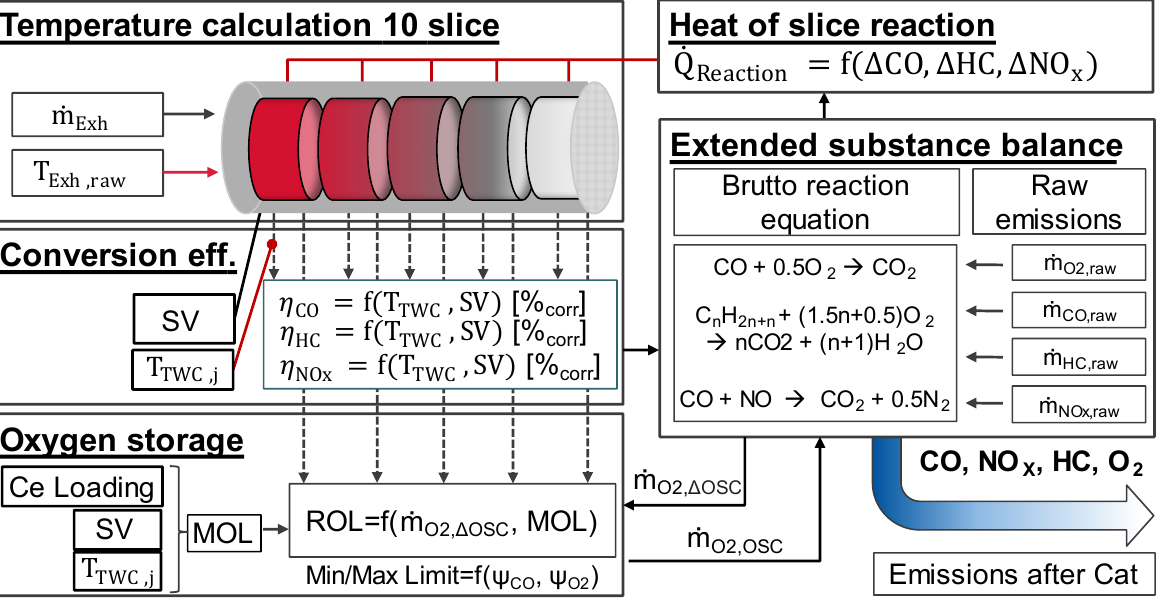
Figure 3. Simplified structure of the three-way catalyst for the main gaseous pollutant conversion.